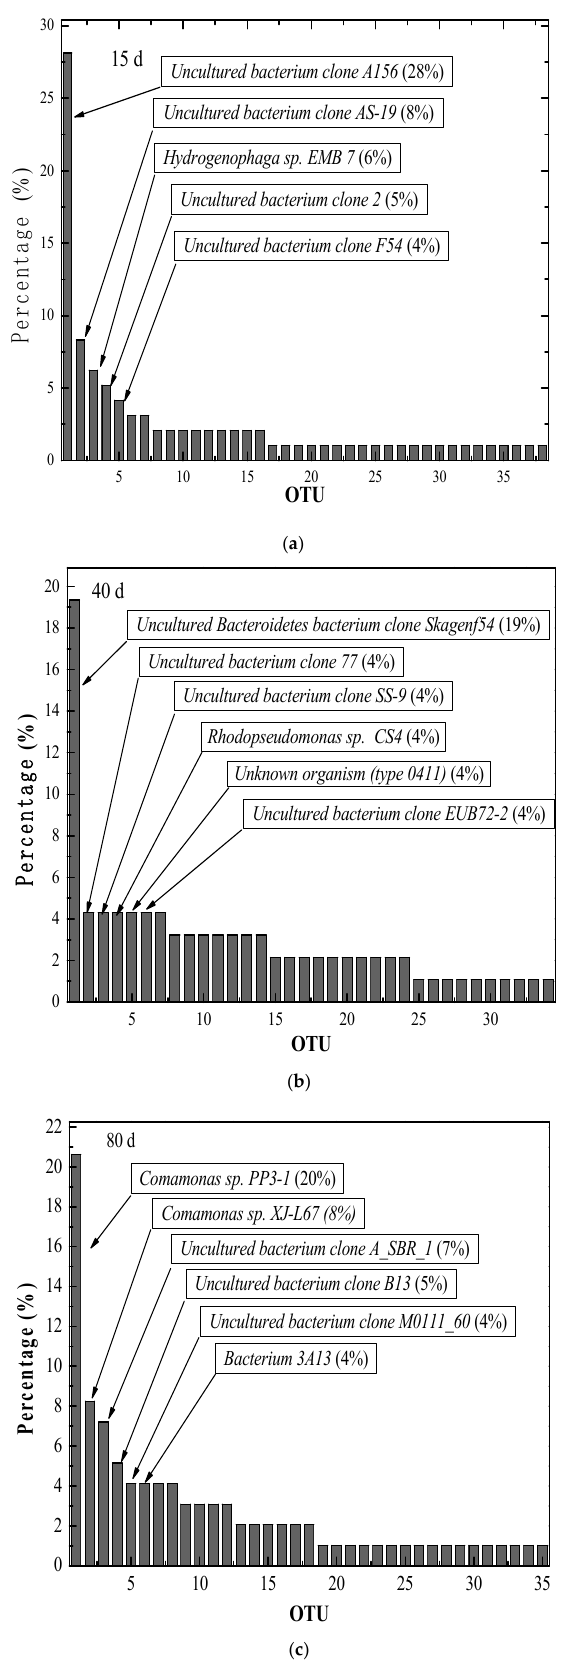
Figure 3. The total bacterial community in AGS at different stages ( a ) 15 d, ( b ) 40 d, and ( c ) 80 d. When the AGS reactor started up, the aerobic granular sludge appeared after 15 days of operation. The OTU number of total bacteria in the reactor was 38, with 77% coverage, and the Shannon–Wiener diversity index was 3.01. The maximum similarity between these clones and the known bacteria in the Gen-bank was 100%, while the